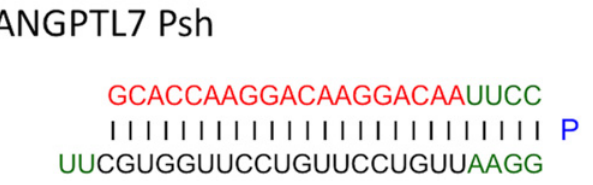
Figure 1. PshRNA platform. PshRNA was synthesized in solid phase as single-stranded RNAs that, following synthesis, self-anneal into a unique helical structure containing a single stem